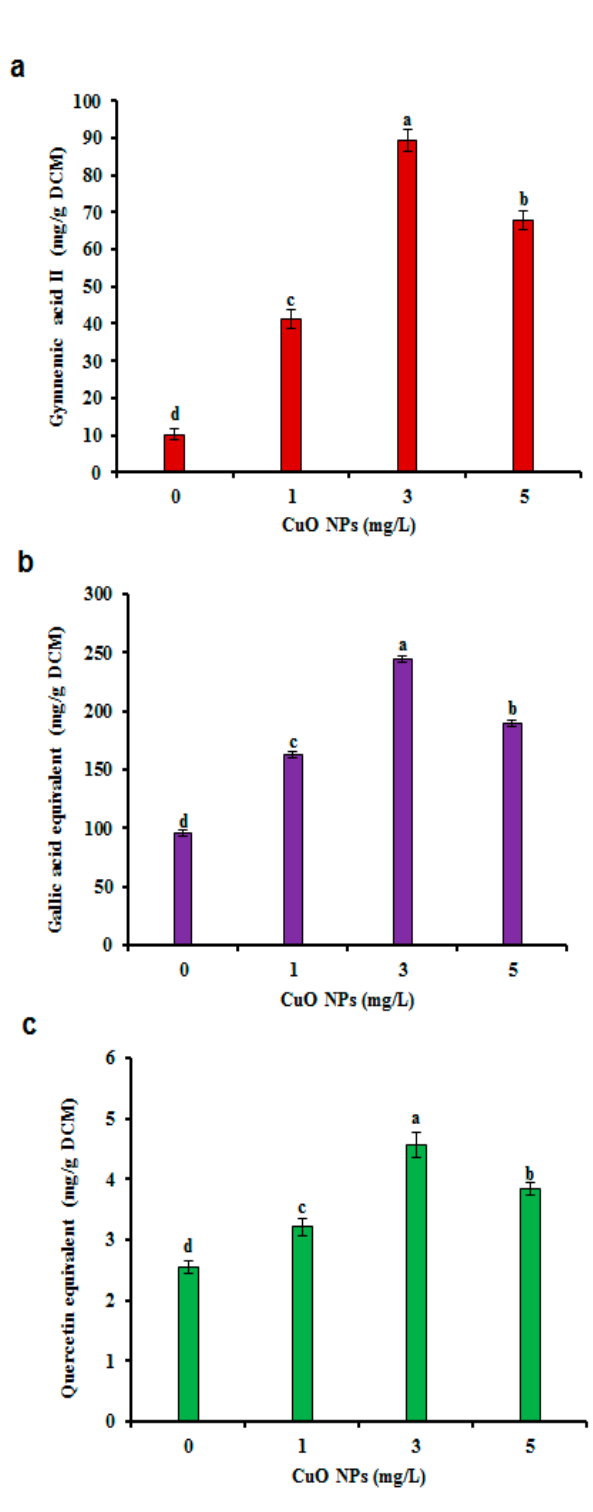
Figure 3. Effect of CuO NPs on bioactive compounds in CSC of G. sylvestre . ( a ) Gymnemic acid II (GA II), ( b ) Total phenolic content (TPC), ( c ) Total flavonoid content (TFC). Different letters indicate a significant difference at p ≤ 0.05.